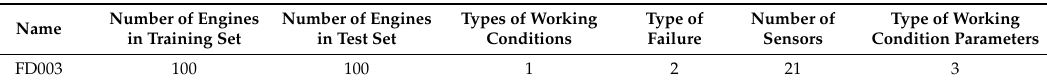
Table 1. FD002 data set details.